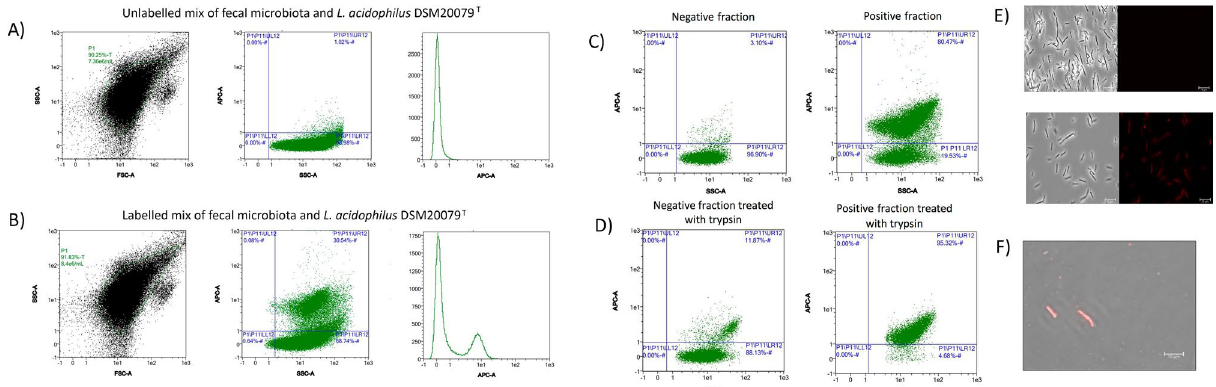
Figure 5. Dispersion diagrams of representative FC experiments showing the acquisition of unlabelled (A) and labelled (B) fecal gut microbiota supplemented with L. acidophilus DSM20079 T . (C) Positive and negative fractions of a microbiota supplemented with DSM20079 T without trypsin pre-treatment. (D) Positive and negative fractions of a microbiota supplemented with DSM20079 T with trypsin pre-treatment. (E) Immunofluorescence microscopy photography showing L. acidophilus labelled and non-labelled with polyclonal antibody anti-SlpA conjugated with APC. (F) Immunofluorescence microscopy photography showing the binding of the APC-anti SlpA antibody to the surface of positive fraction after trypsin treatment.